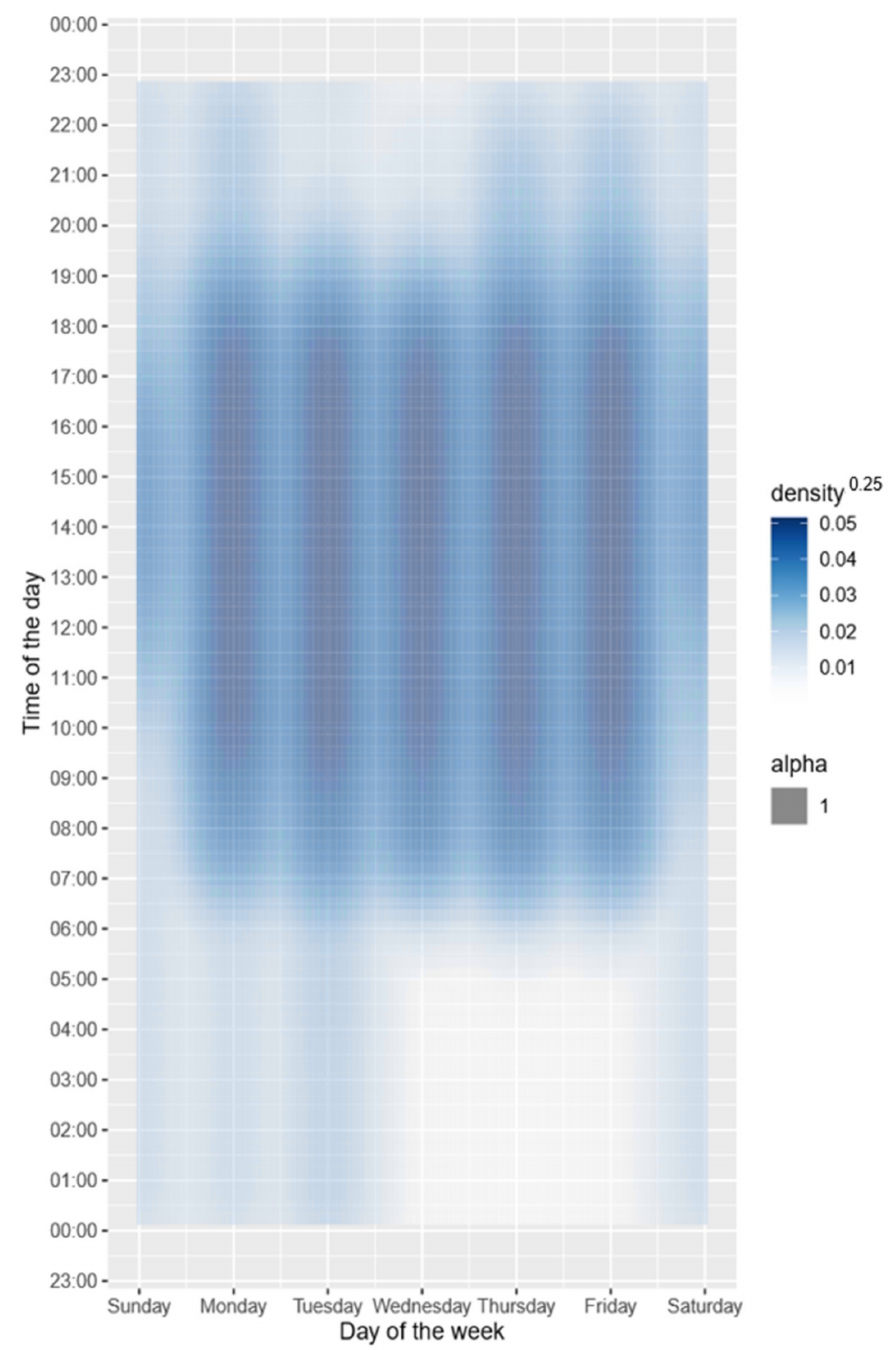
Figure 5. Occupancy graph of the building during